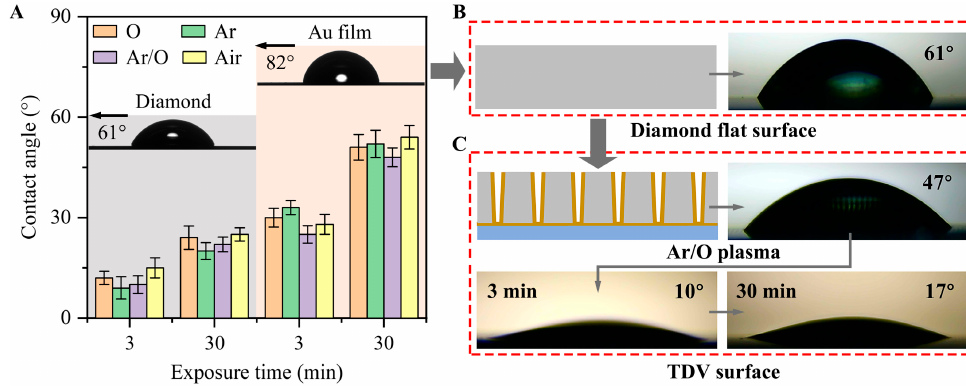
Figure 3. ( A ) Contact angles of the electrolyte on the diamond and Au flat surfaces under short ‐ term exposure to air after plasma irradiation. Droplet shape on different diamond patterns, ( B ) flat diamond surface without plasma treatment, and ( C ) TDV surface without plasma treatment and short ‐ term exposure to air after Ar/O plasma irradiation after Cr/Au deposition and temporary bonding.